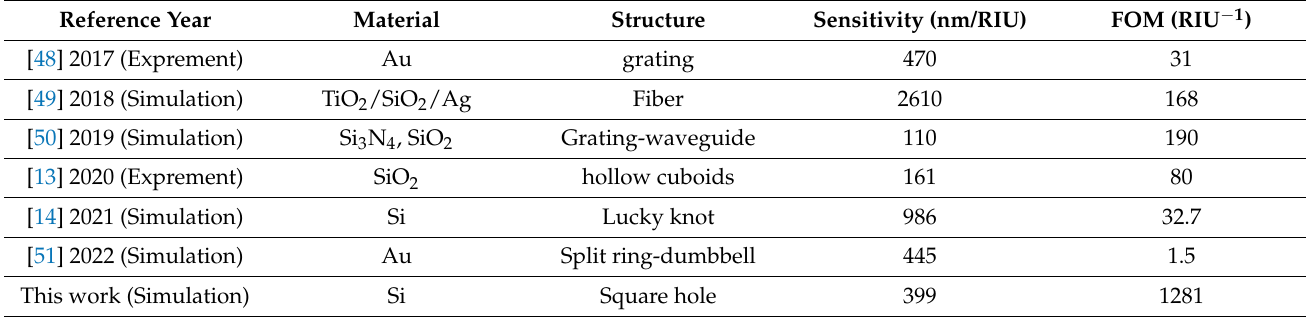
Table 1. Comparison of sensitivity and FOM for various